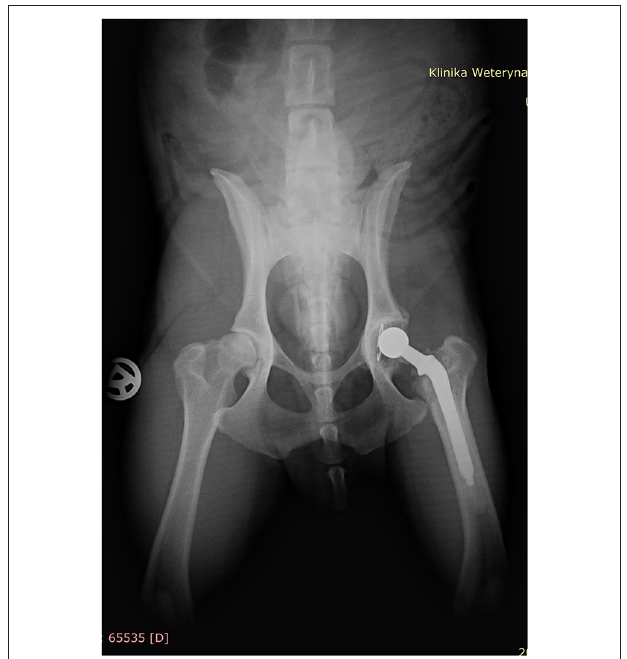
FIGURE 1 | Ventrodorsal radiograph of the dog 2 years after cemented total hip replacement (left hip); radiopaque cement mantle surrounding the femoral and acetabular component is